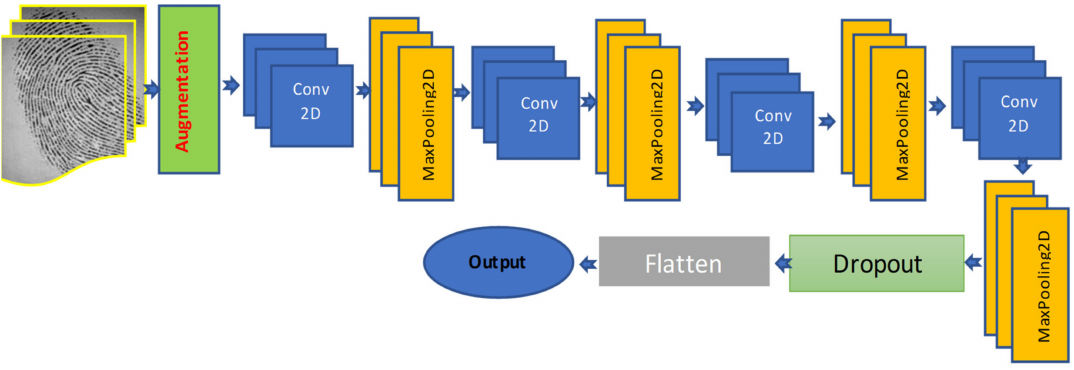
Figure 3. CNN model architecture. Table 2. Model architecture and parameter